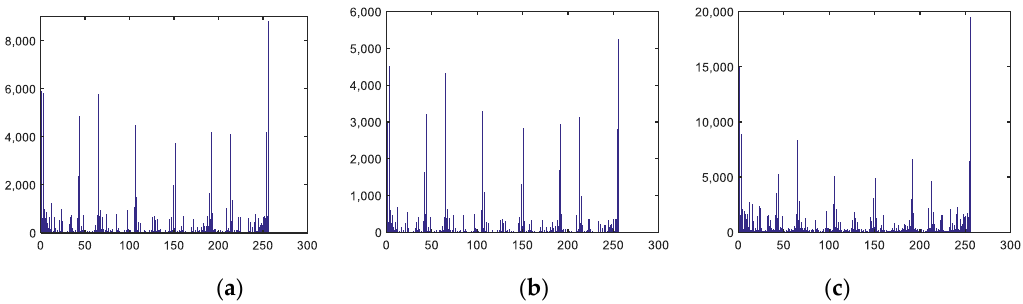
Figure 5. Comparison of the LBP histograms. LBP histograms computed from ( a ) an original speech, ( b ) the down-resampled speech ( p/q = 0.6), and ( c ) the up-resampled speech ( p/q = 2.0).